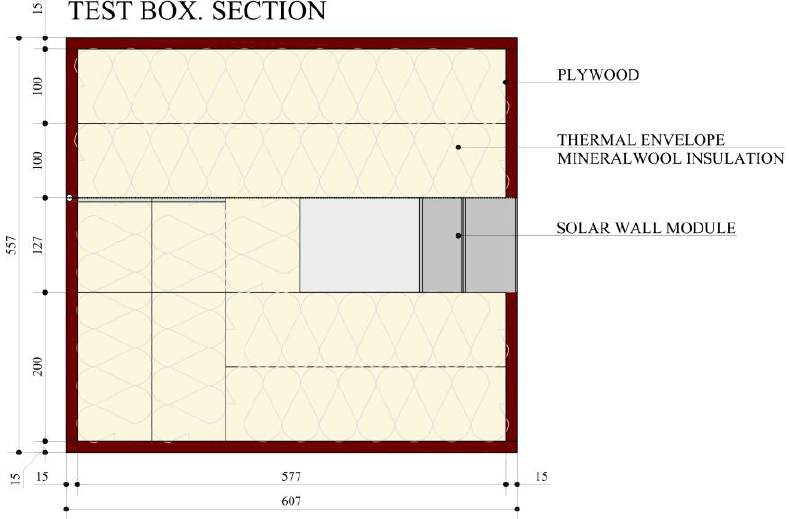
Fig. 3. Solar module in a test